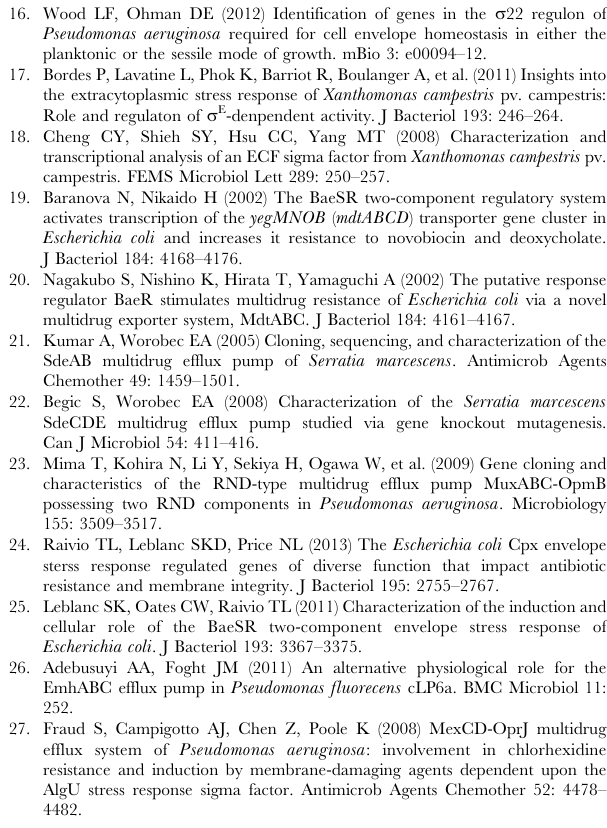
Figure S1 Schematic organization of the smeIJK operon and its derived mutants of S. maltophilia . The smeIJK operon contains genes for a membrane fusion protein ( smeI ) and two RND transporters ( smeJ and smeK ). The orientation of gene is indicated by the arrow. The solid lines, labeled as I to IV, represent the PCR amplicons for the construction of recombinant plasmids. The numbers in the brackets represent the PCR amplicon size (bps). The white box indicates the deleted region for each mutant construct. Figure S2 Schematic organization of the rpoE-rseA- mucD cluster , its derived mutants and the predicted s E binding site upstream of the rpoE in S. maltophilia . The orientation of gene is indicated by the arrow. The white box indicates the deleted region. The each protein identity of the rpoE region between X. campestris pv. campestris and S. maltophilia is indicated. The gray lines, labeled as I to III, represent the PCR amlpicons for the construction of recombinant plasmids. The numbers in the brackets represent the PCR amplicon size (bps). The sequence of the putative rpoE promoter region is shown below the map. The putative 2 35/ 2 10 regions are underlined,